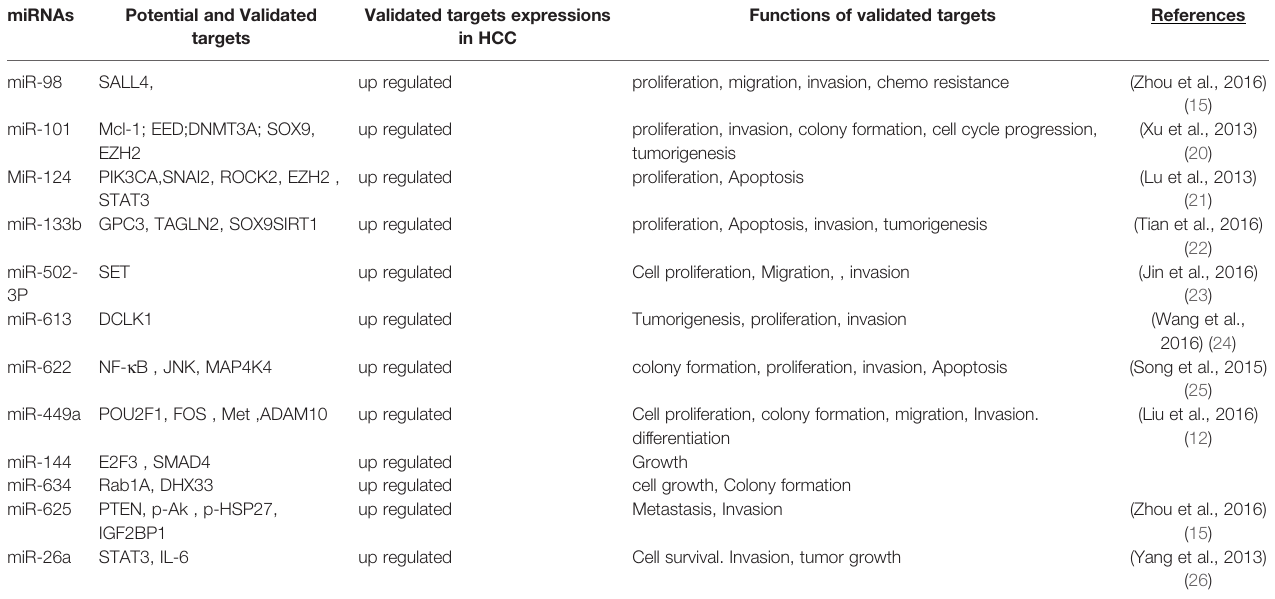
TABLE 2 | Down regulated miRNAs and their target genes in hepatocellular carcinoma. miRNAs Potential and Validated